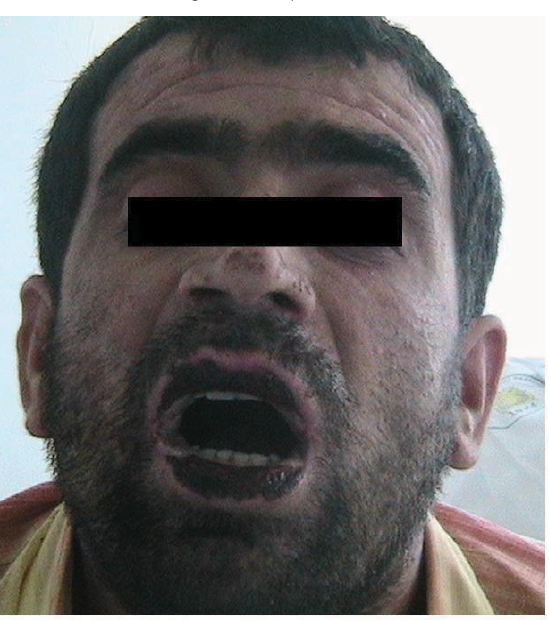
Figure 2. Erythematous typical target macules tending to combine with each other and scattered Nikolsky’s sign positive blisters on the